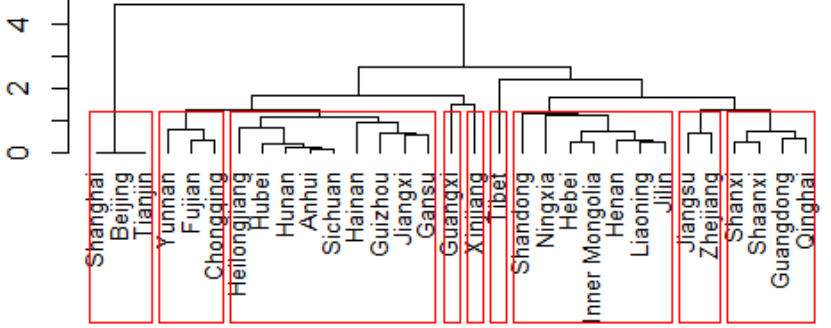
Figure 5. Result of average linkage clustering.